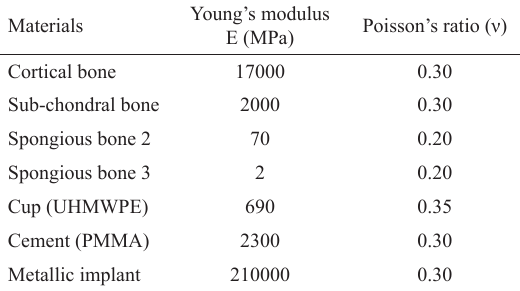
Table 1: Materials' properties 31,32 .